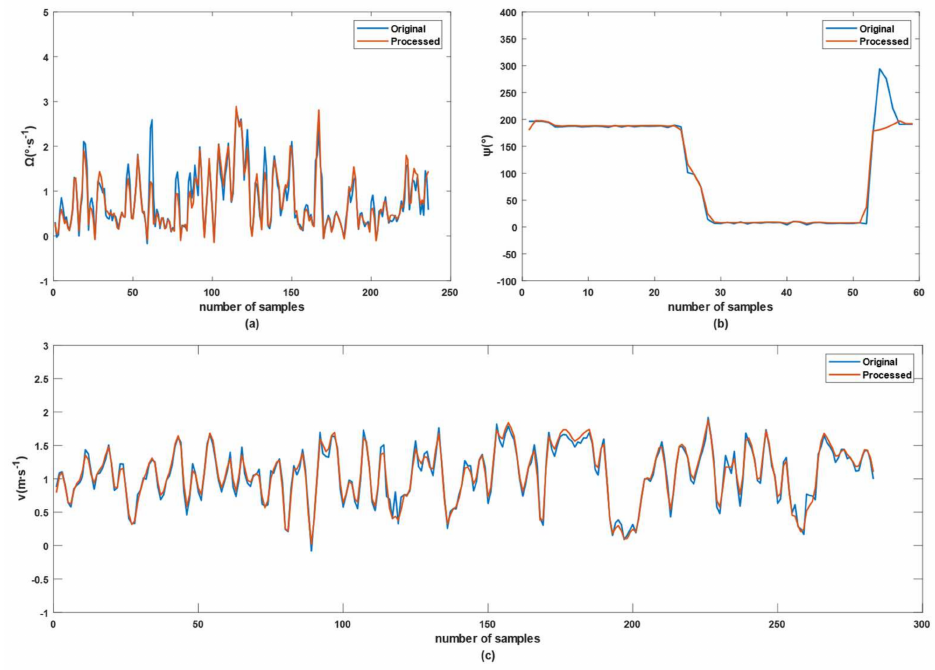
Figure 6. Graph of denoising results: ( a ) optimization results of Ω ; ( b ) optimization results of ψ ; ( c ) optimization results of v